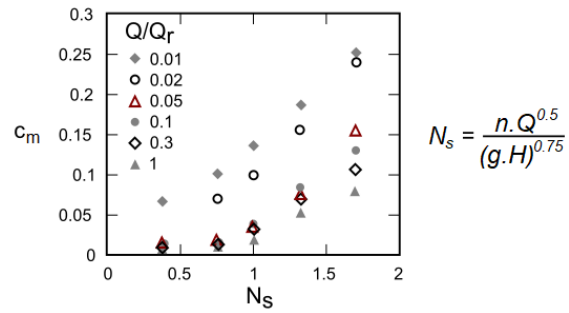
Figure 16. Disk friction coefficient for different specific speed and different capacity ratio